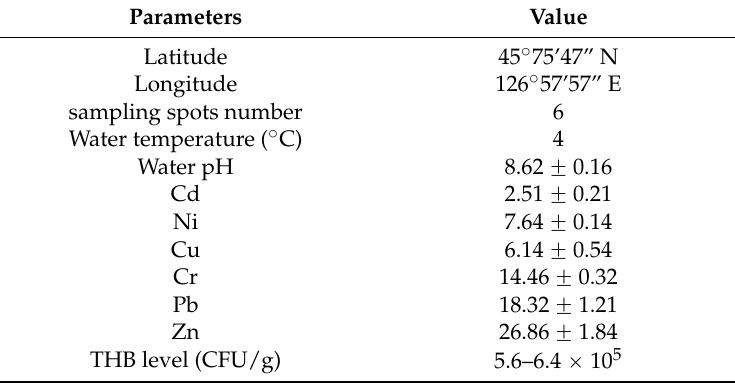
Table 1. Metal concentration (mg/kg) in sampling spots of the study